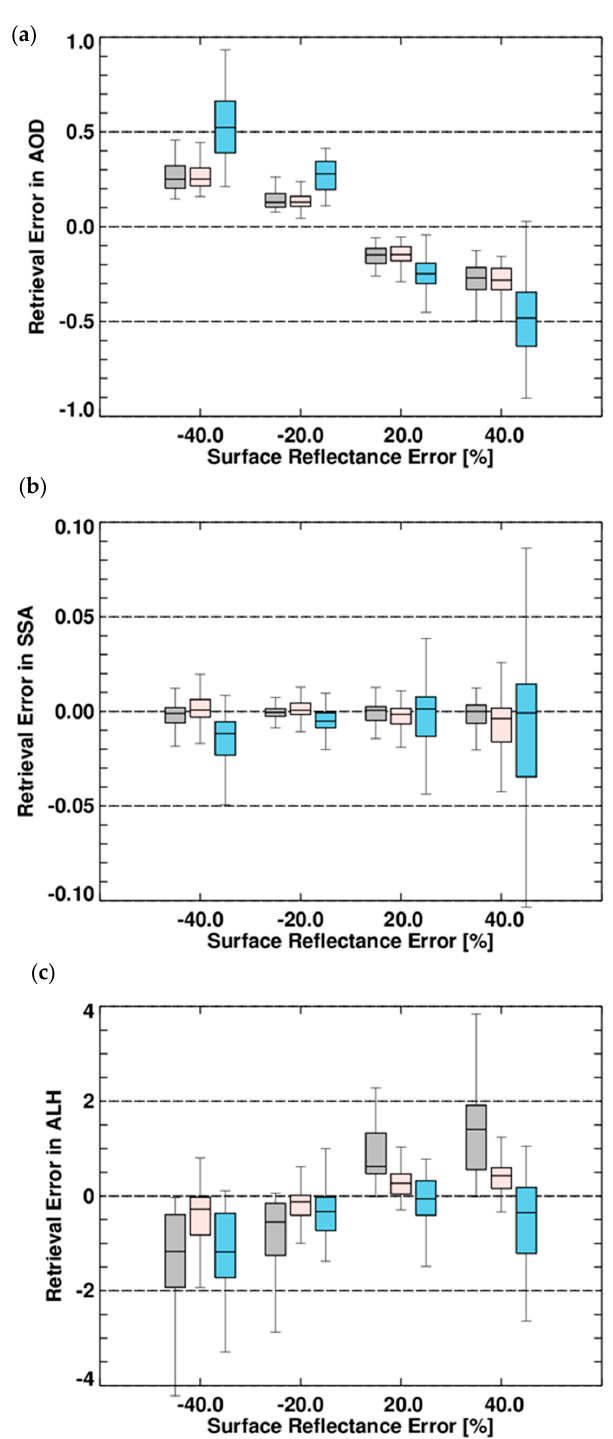
Figure 12. Retrieval error in ( a ) AOD, ( b ) SSA and ( c ) ALH (km) due to errors in surface reflectance for each aerosol type. Gray: HAF, pink: Dust and blue: NA. Errors are obtained by testing the algorithm with four LERs that are –40%, –20%, 20% and 40% from the true condition of 0.06. Each box-and-whisker plot for a given LER error condition shows the retrieval error distribution derived from the 108-member ensemble for AOD and SSA and 81-member ensemble for ALH.